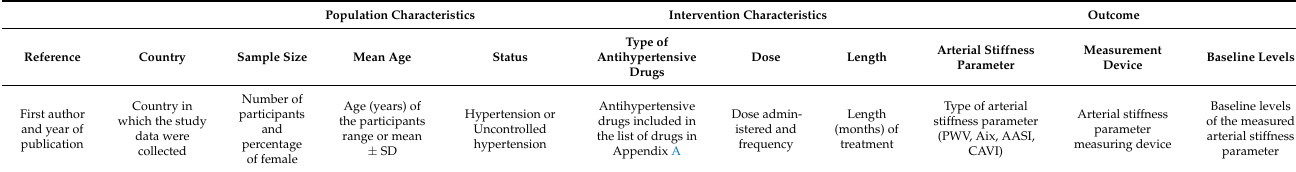
Table 2. Characteristics of studies